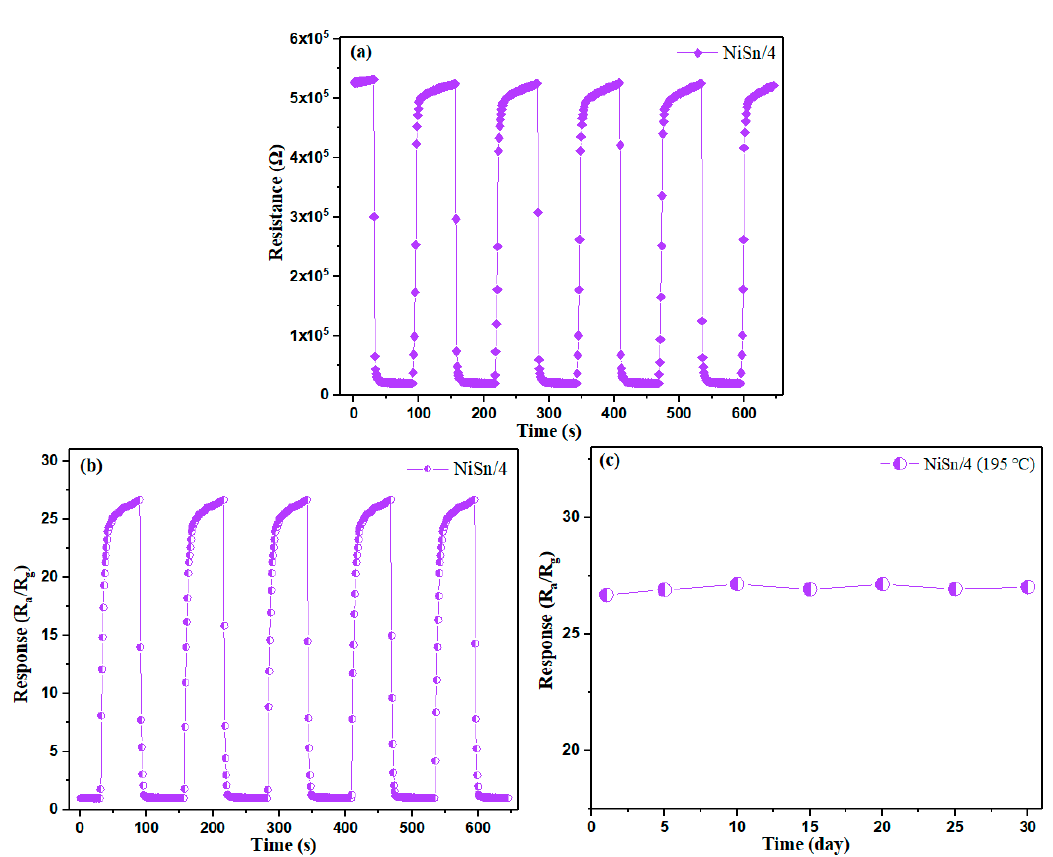
Figure 9. ( a ) The electric resistance properties of NiSn/4 sensor to 50 ppm H 2 at 195 °C and ( b ) the corresponding dynamic gas-sensing curve. ( c ) The long stability of NiSn/4 sensor to 50 ppm H 2 at 195 °C.